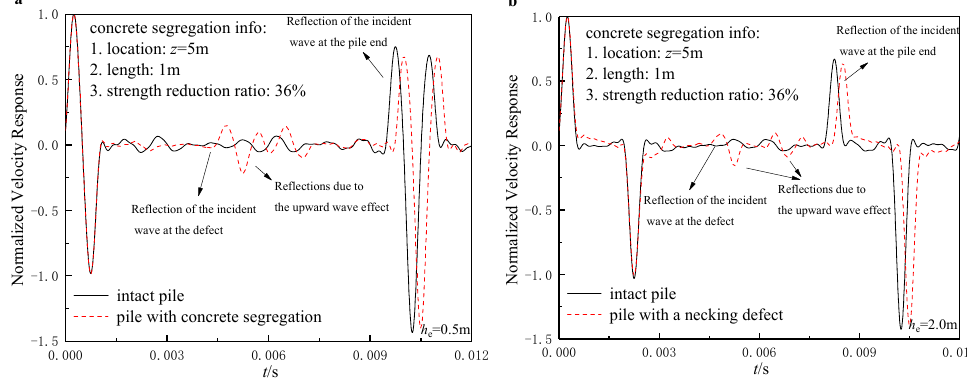
Figure 7. Identification of concrete segregation through TLSIT: ( a ) h e = 0.5 m; ( b ) h e = 2.0